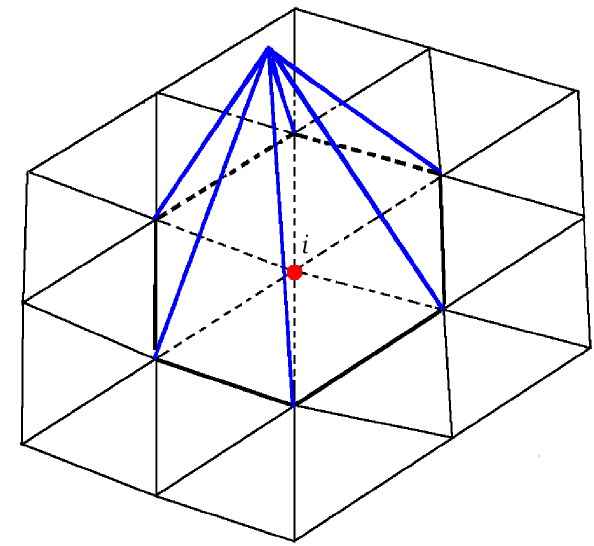
Fig. 1. Schematic of horizontal discretization with the illustration of basis functions used in FESOM. The stencil mentioned in the Fig. 11. Schematic of horizontal discretization with the illustration text consists of seven nodes for node i in the example shown in this of basis functions used in FESOM. The stencil mentioned in the text consists of seven nodes for node i in the example shown in this figure.